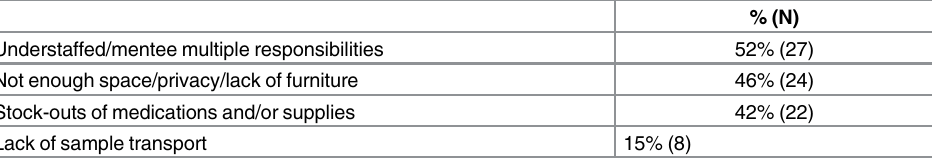
Table 3. Challenges of EQUIP Mentorship (N =